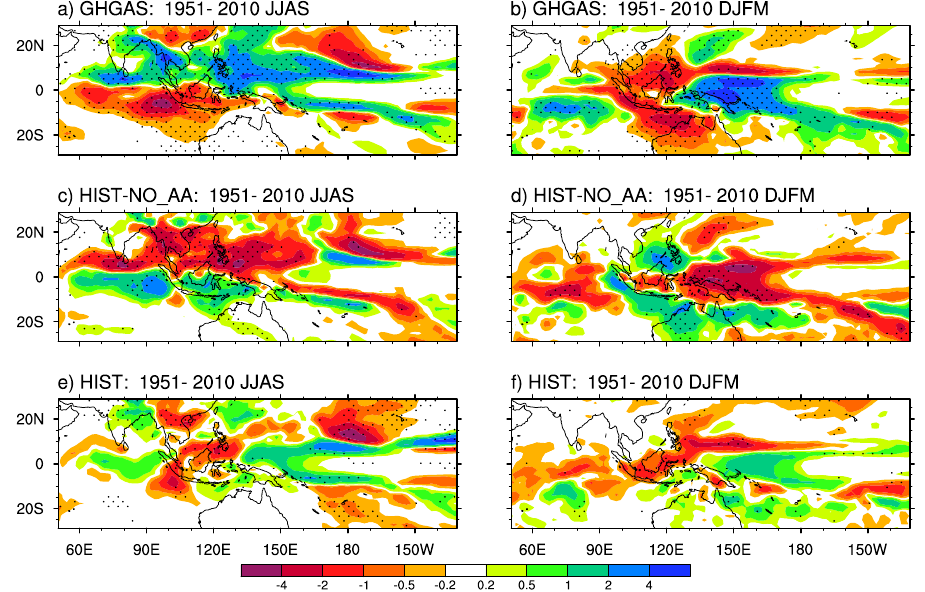
Fig. 10. Simulated rainfall trends (mmday − 1 century − 1 ) for 1951–2010, from (a) GHGAS for JJAS, (b) GHGAS for DJFM, (c) HIST minus NO AA for JJAS, (d) HIST minus NO AA for DJFM, (e) HIST for JJAS, (f) HIST for DJFM. Stippled trends are significant at